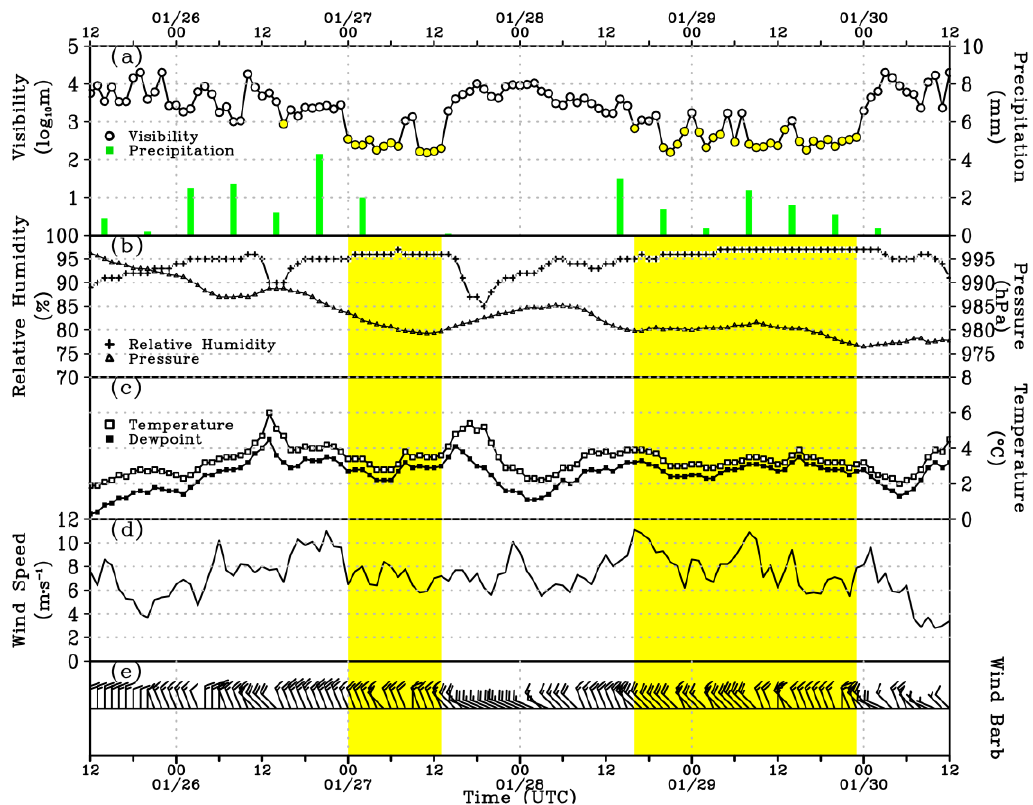
Figure 2. Time series for the hourly visibility and 6-hourly precipitation ( a ), relative humidity and surface pressure ( b ), surface air temperature and dewpoint temperature ( c ), wind speed ( d ), and wind barb ( e ) at the Great Wall Station. The yellow shades show the period corresponding to the appearance of sea fog. The x axis is time.